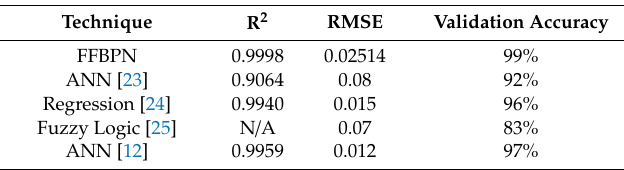
Table 6. Performance Comparison of FFBPN with previous